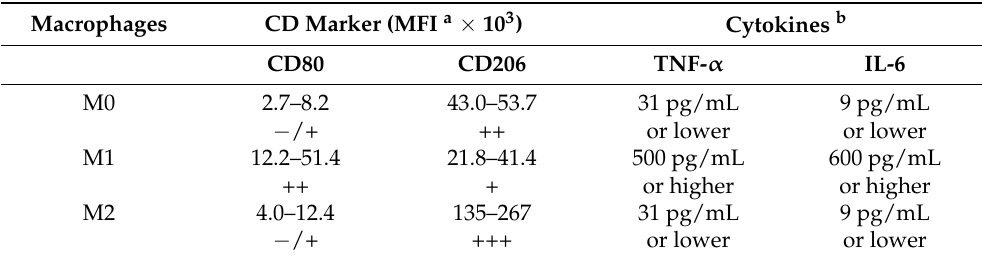
Table 1. Expression of CD markers and cytokine production by in vitro differentiated and polarized macrophages. Macrophages CD Marker (MFI a × 10 3